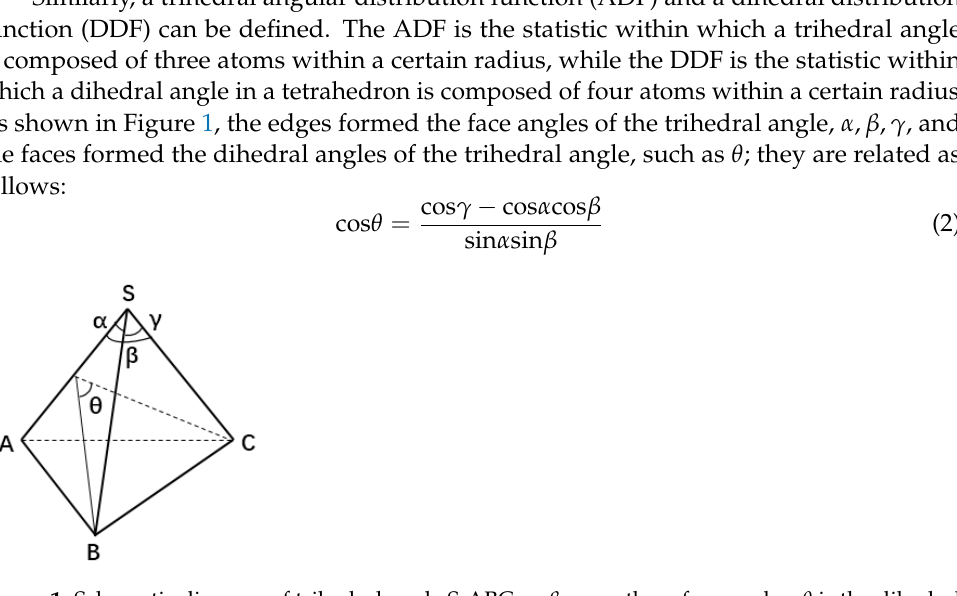
Figure 1. Schematic diagram of trihedral angle S-ABC; α , β , γ are three face angles; θ is the dihedral between two planes (cid:52) SAB and (cid:52)